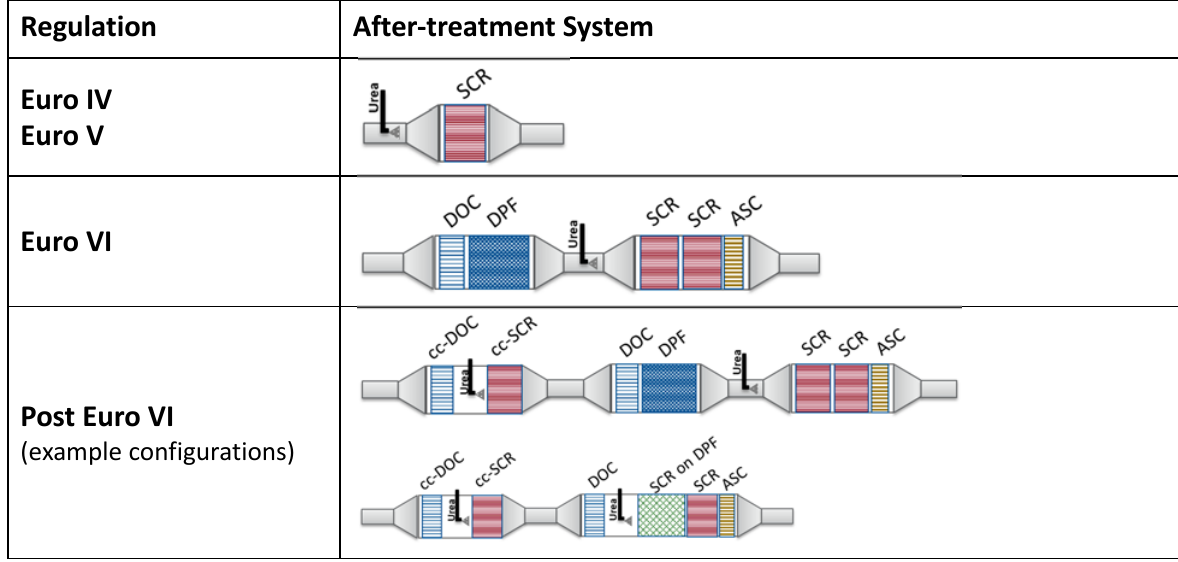
Figure 4. Evolution and newly proposed ATS configurations for Diesel HDV.